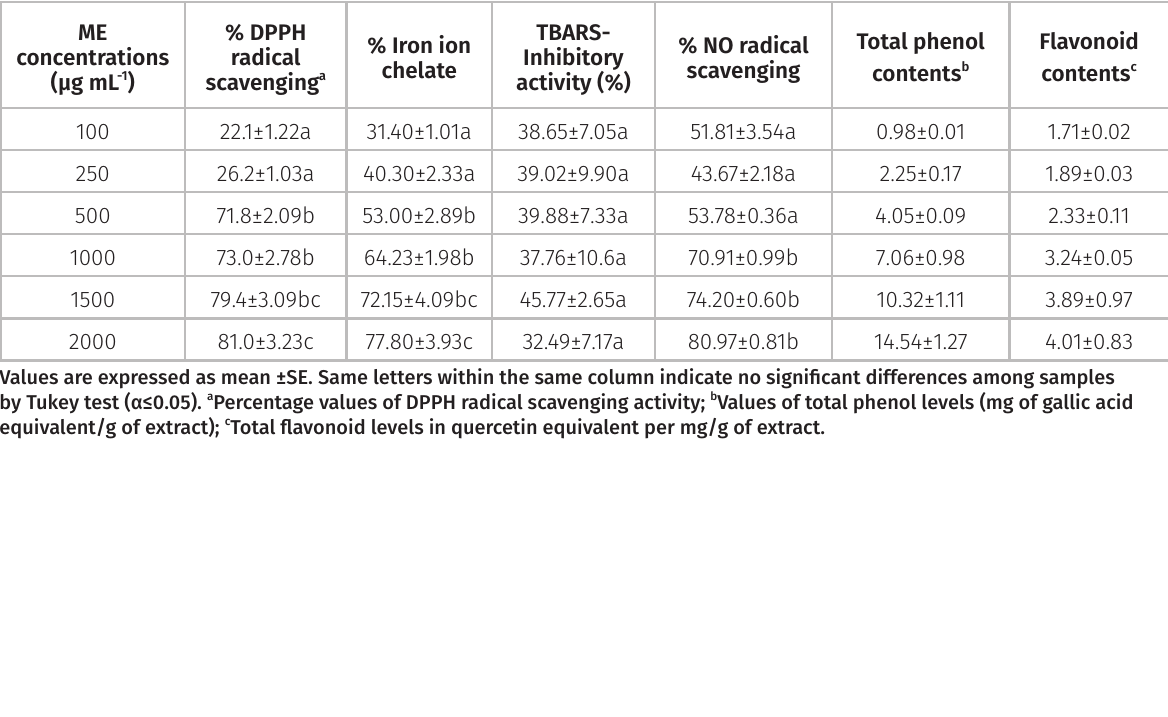
Table III. DPPH radical scavenging activity, iron ion chelating power, inhibition of lipid peroxidation (TBARS), NO radical scavenging and determination of total phenols and flavonoids at different concentration of methanolic extract (ME) of C. antisyphiliticus